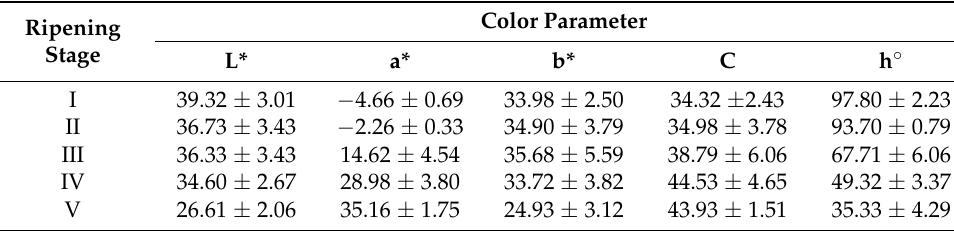
Table 2. Color parameters change of rosehip at ripening stage (average for 2018–2020 years).